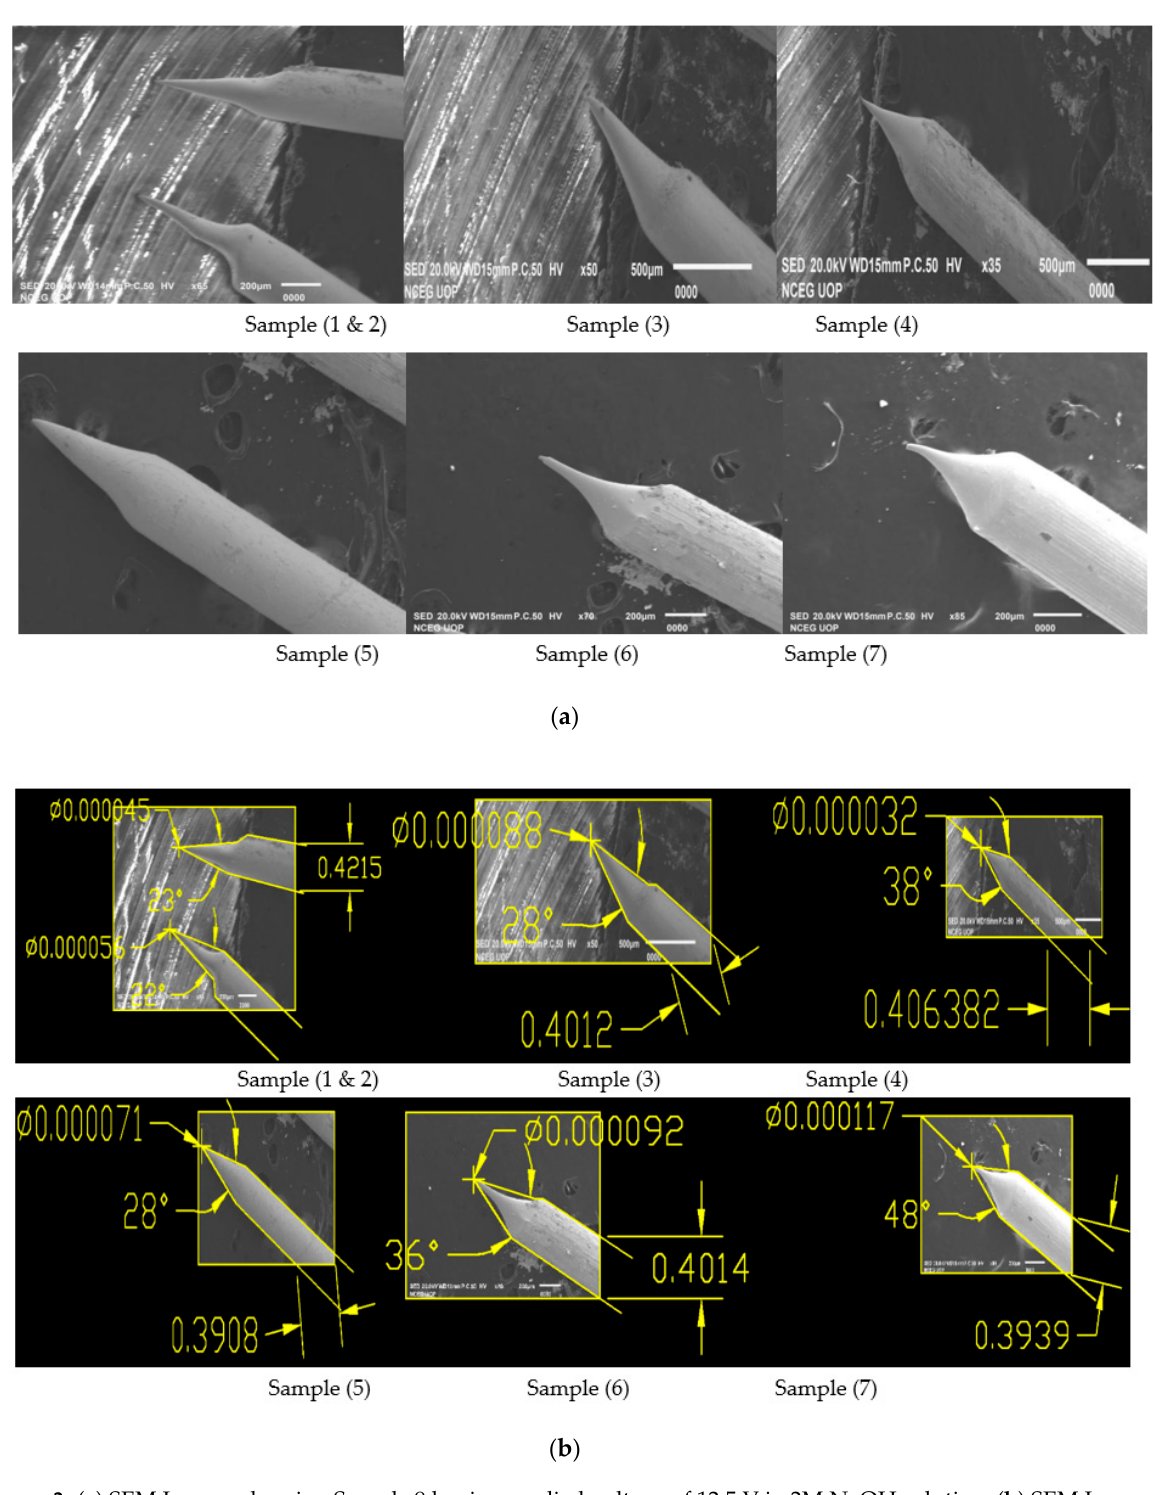
Figure 3. ( a ) SEM Images showing Sample 9 having applied voltage of 12.5 V in 2M NaOH solution; ( b ) SEM Images of tungsten tips showing sample 9 cone angle and tip diameter measured using AutoCAD Software.